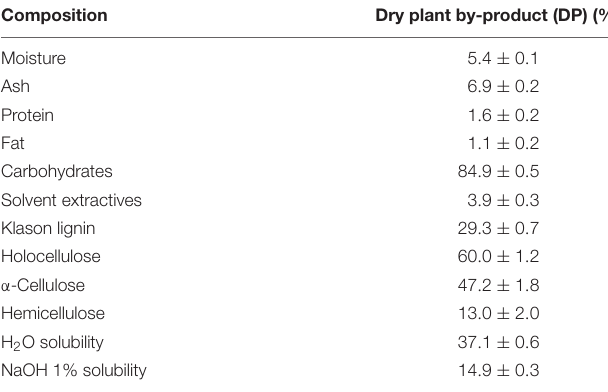
TABLE 1 | Chemical composition of DP ( n = 3, mean ±